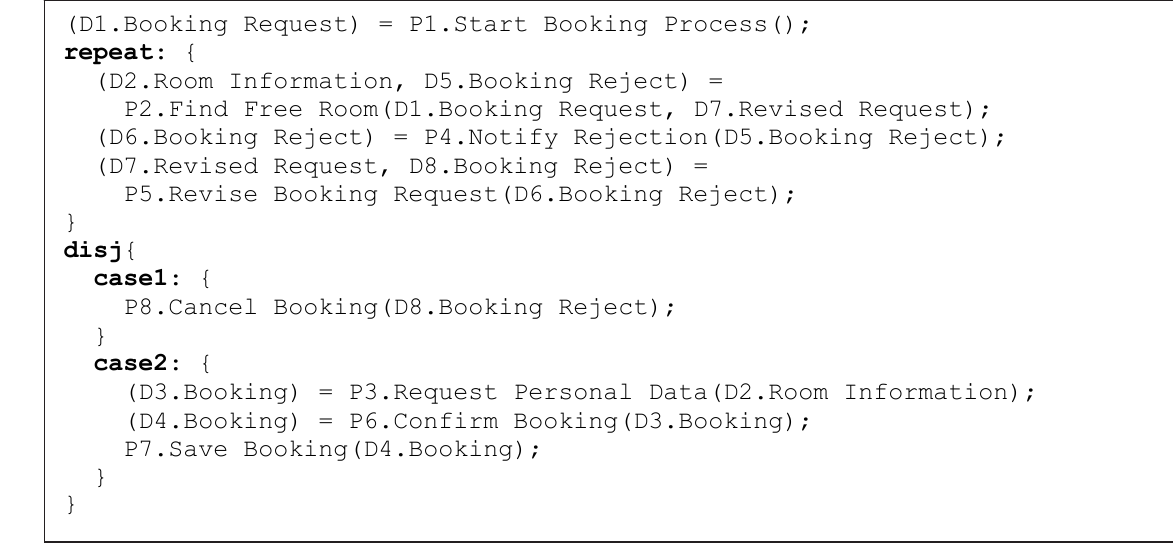
Fig. 17. Generated workflow